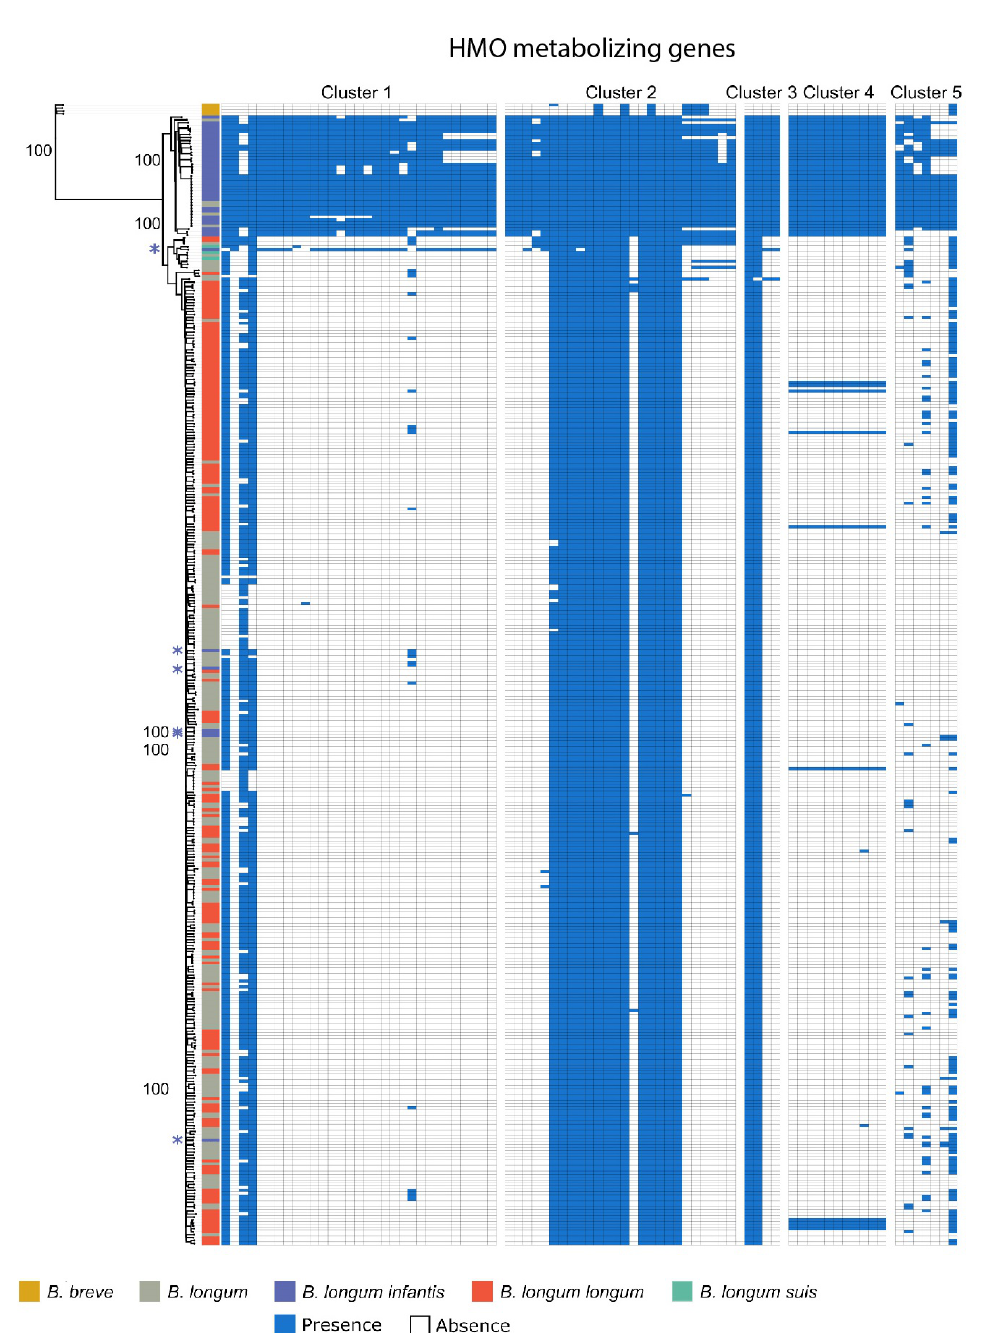
Figure 2. HMO-metabolizing gene clusters mirror phylogenetic separation of B. infantis . Rooted neighbor-joining tree of the average nucleotide identity (ANI) values of the same 387 Bifidobacterium genomes with HMO-metabolizing genes removed (Supplementary Materials Table S3). The tree is paired with a heatmap denoting the presence of HMO-metabolizing genes by BLASTN alignments (>95% identity). Potentially misclassified B. infantis genomes noted with a purple